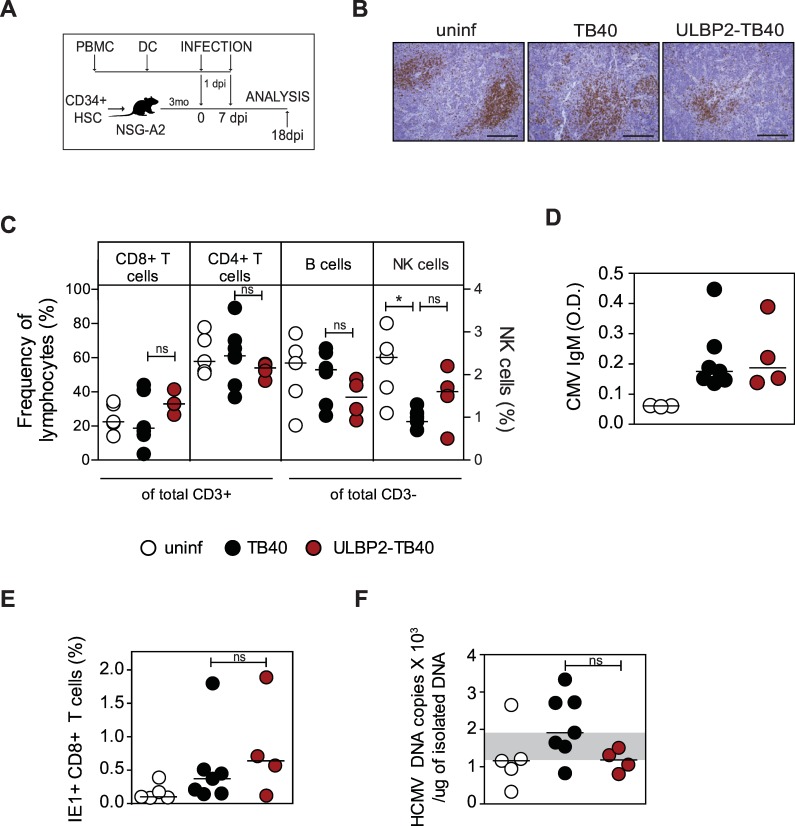
Immunogenicity of the ULBP2-TB40 strain in humanized mice.(A) Experimental design for immunization of humanized mice with the HCMV strains. DC generated from HLA-A2+ HCMV-negative donors were infected or left uninfected and 1 day p.i. injected into NSG-A2 humanized mice. Mice were boosted 7 days later in the same manner. On day 18 p.i. mice were sacrificed and the frequency of HCMV-specific CD8+ T cells and viral load were analyzed. (B) Representative immunohistological images of spleens from one animal of each group after staining with a CD3 antibody. Scale bar, 200 μm. (C) Percentages of human CD8+ and CD4+ T cells out of total CD3+ cells and of CD19+ B cells and CD56+ NK cells (right y-axis in red) out of total CD3- cells in spleens of animals from the uninfected group (white circles), or groups receiving TB40 (black circles) and ULBP2-TB40 infected DC (red circles). (D) CMV-specific IgM antibodies in serum of infected animals detected by ELISA. (E) Percentage of IE1-tetramer+ CD8+ T cells in spleens of animals for the indicated groups. (F) Viral load in spleen at day 18 p.i. Each circle represents the result for one animal and lines indicate medians. Data from all panels was analyzed using the Mann-Whitney t-test. *, P < 0.05. ns, P > 0.05.